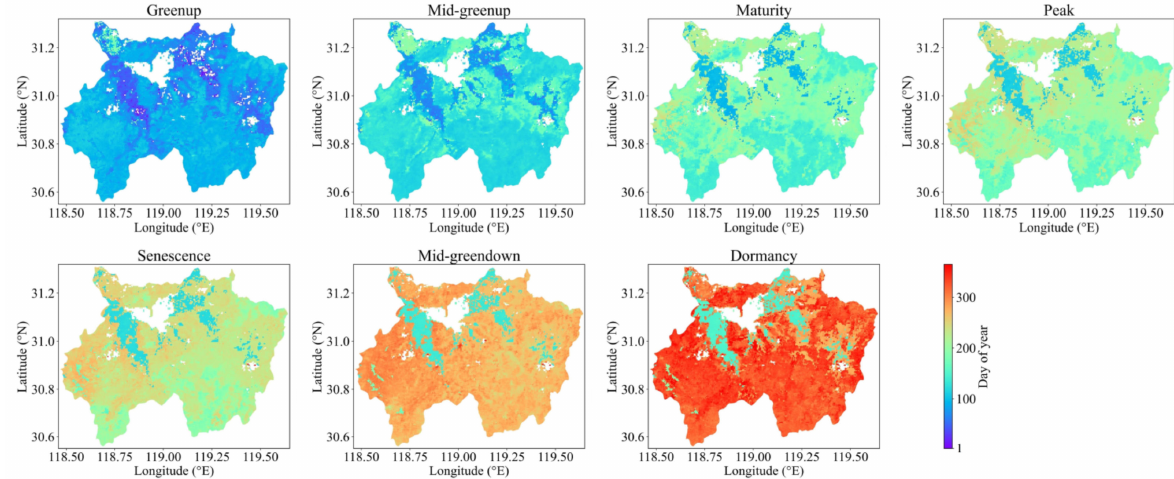
Figure 2. Maps of averaged values of phenological variables from 2002 to 2011 extracted from the land cover dynamics product (MCD12Q2) for the study